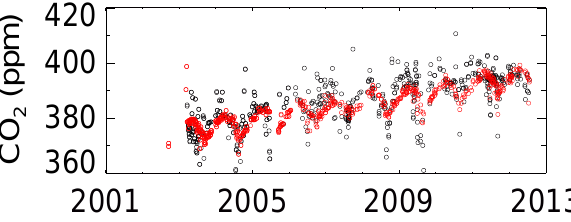
Fig. 10. Time series of CO 2 vertical profiles collected from Septem- ber 2002 through July 2012 from flasks collected at 3000m (above the PBL, red circles, N = 740) and 1000m (below the PBL, black circles, N = 604).